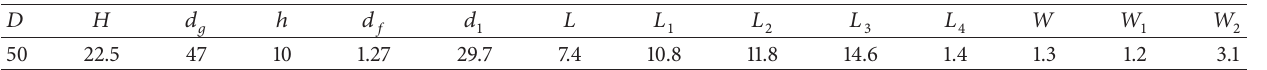
Figure 1: Configuration of the proposed antenna. (a) Top view. (b) Side view. Table 1: Dimensions of the proposed antenna (unit: